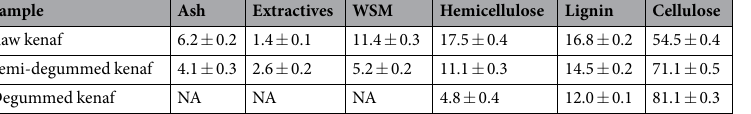
Table 1. Chemical compositions of raw kenaf, semi-degummed kenaf and degummed kenaf (%). Note: there is 25% weight loss after the steam explosion and additional 12% weight loss after the chemical degumming treatment. WSM represents water soluble matter.